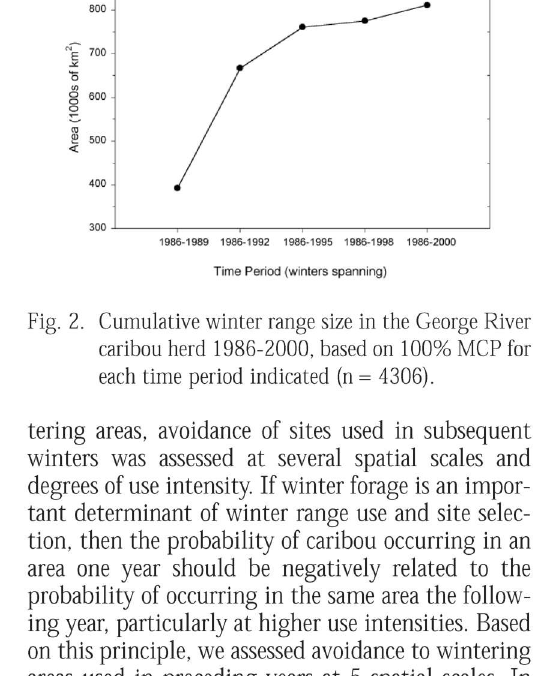
Fig. 2. Cumulative winter range size in the George River caribou herd 1986-2000, based on 100% MCP for each time period indicated (n = 4306).